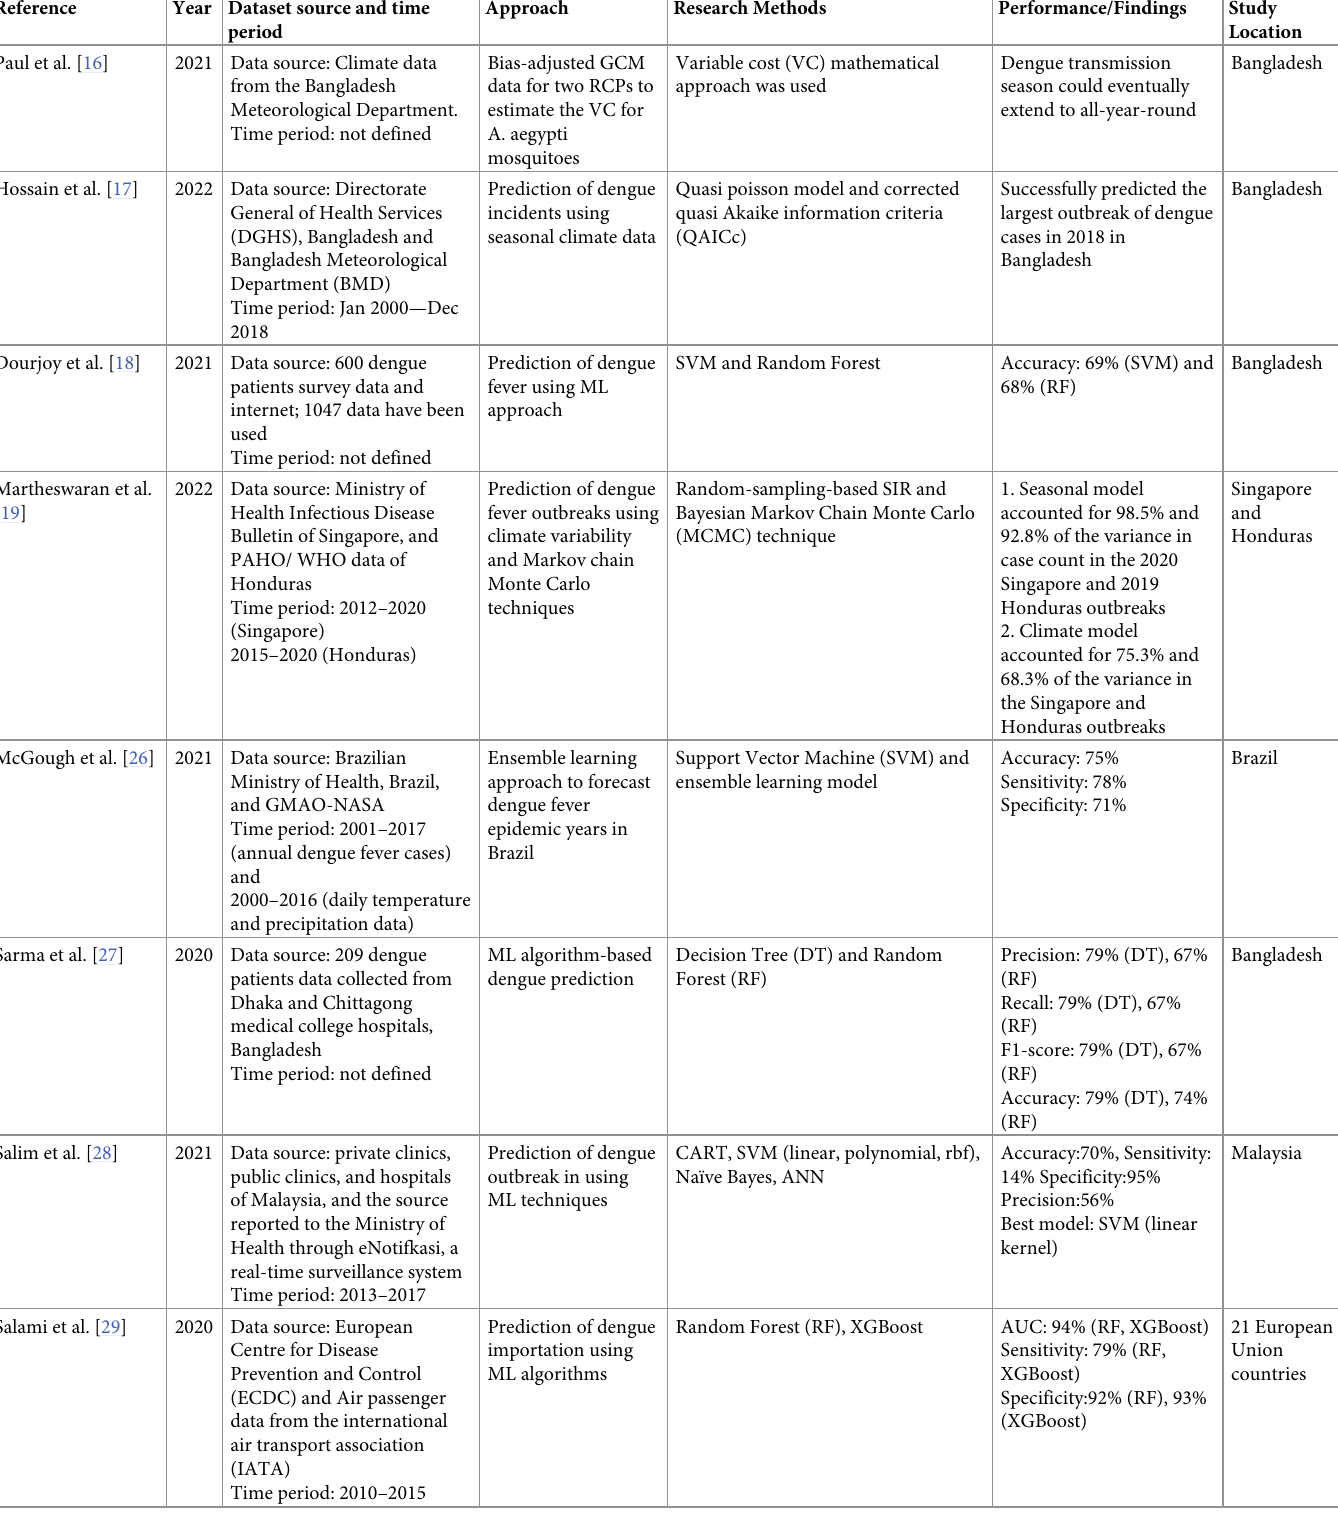
Table 3. Comparative analysis of state-of-the-art research work in predicting dengue incidents globally using different data sources.